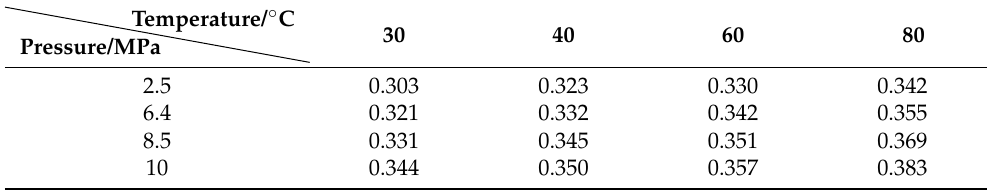
Table 1. Fractional free volume of gas molecules in PVDF at different